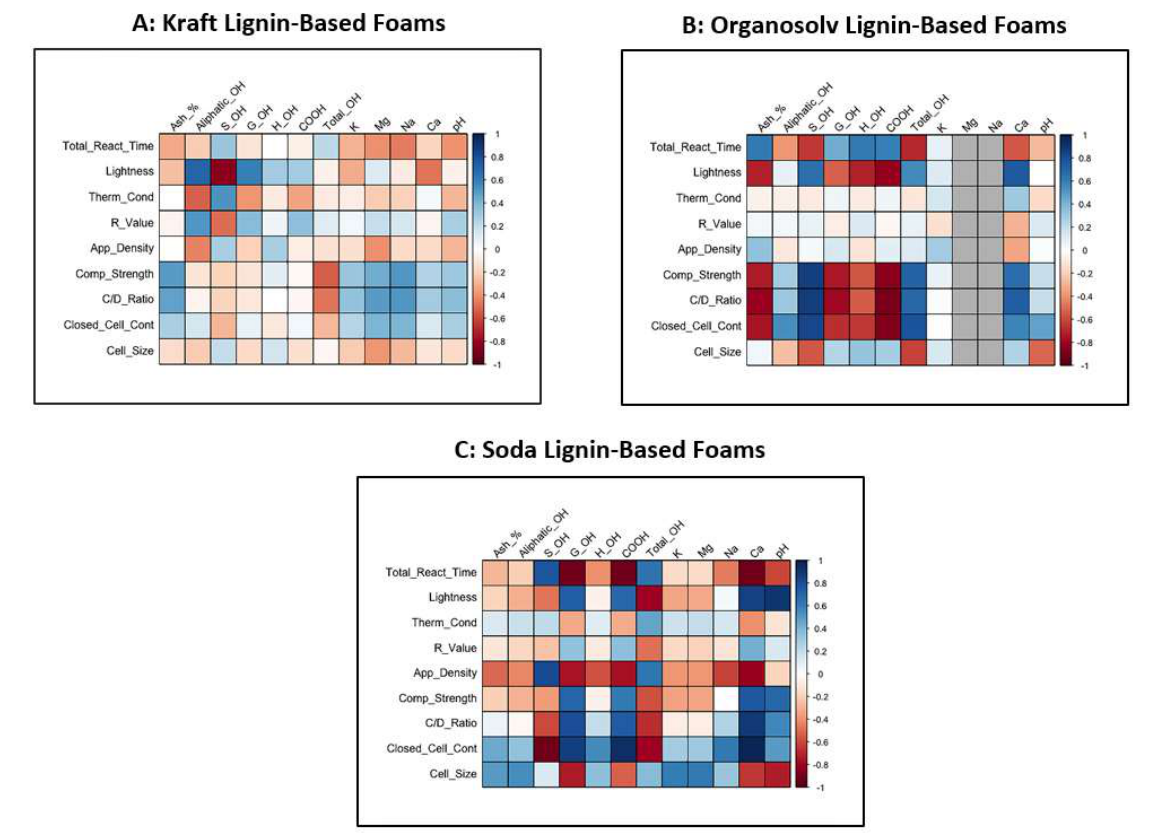
Figure 2. Heat map of correlations (r ranges from 1 to − 1) between lignin properties vs. lignin-based foam performance based on ( A ) kraft lignin-based foams, ( B ) organosolv lignin-based foams, ( C ) soda lignin-based foams. Values above ± 0.7 show a high correlation. Table 3. Measured properties of formulated foams.